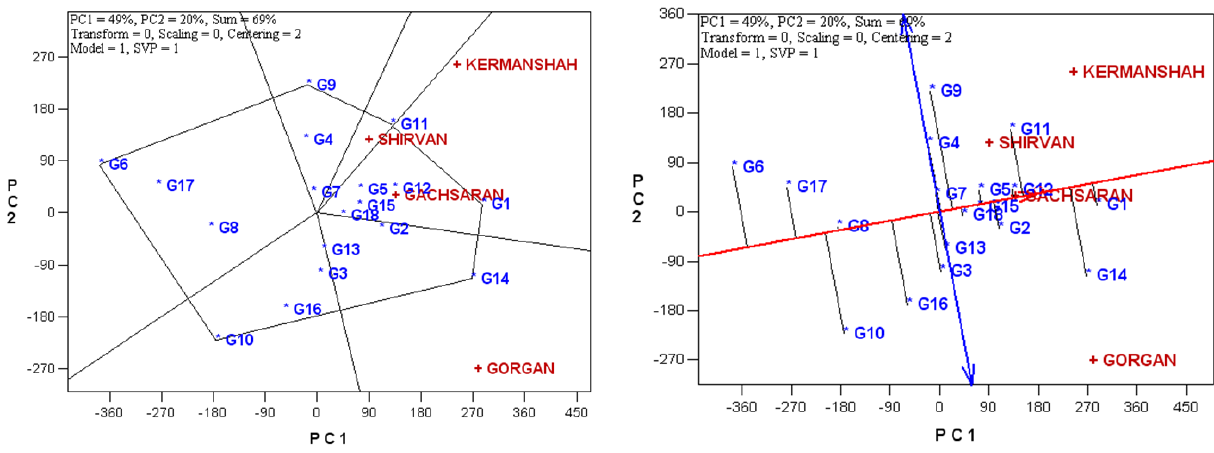
Fig. 1. GGE biplot identification of winning genotypes and their related mega-environments